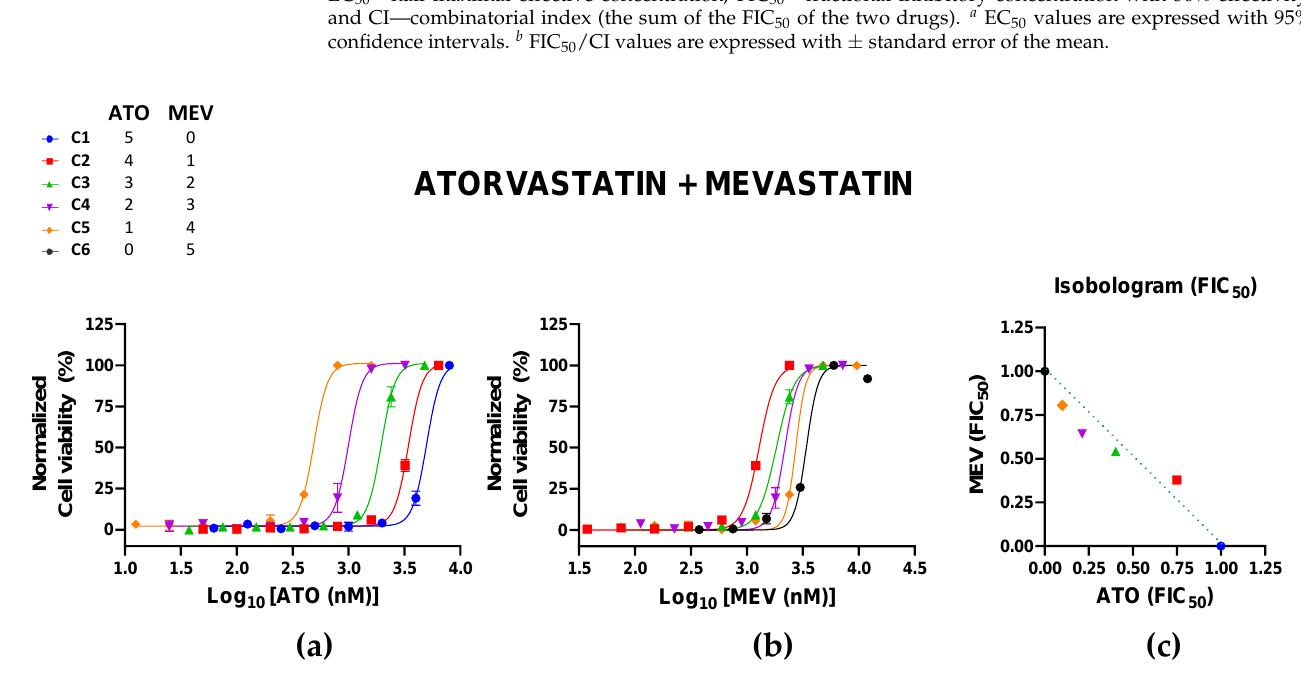
Figure 1. Effects of the combination of atorvastatin (ATO) and mevastatin (MEV) on Zika virus (ZIKV) infection. Vero cells were infected with ZIKV (MOI of 0.02) and treated with different combinations of ATO and MEV. Normalized cell viability of ZIKV-infected cells in response to the different concentrations of ( a ) ATO and ( b ) MEV in their different combinations are shown. All datapoints represent the mean ± SEM of 2 independent experiments per combination. ( c ) The normalized isobologram was constructed based on the mean FIC 50 of each statin (Table 1). Colors and symbols in the legend correspond to those in ( a – c ).